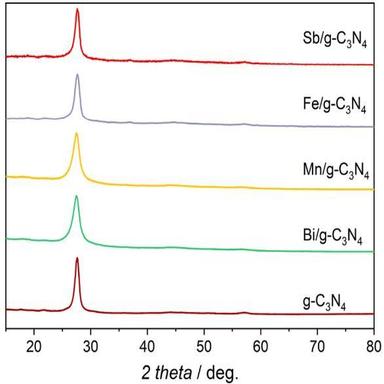
XRD pattern of the synthesized g-C3N4 materials.